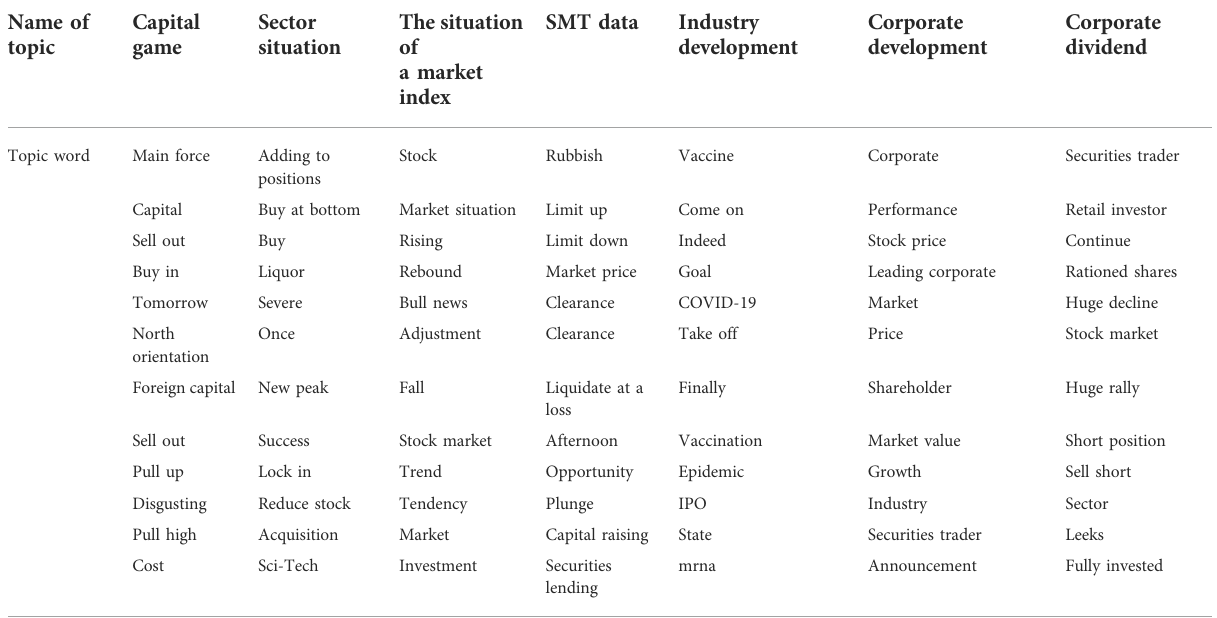
TABLE 3 Top twelve keywords for each